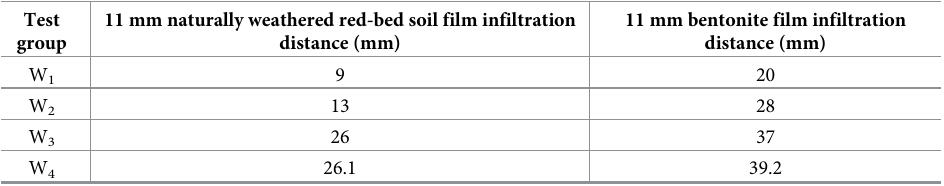
Table 6. Comparison of properties between 11 mm bentonite films and naturally weathered red-bed soil